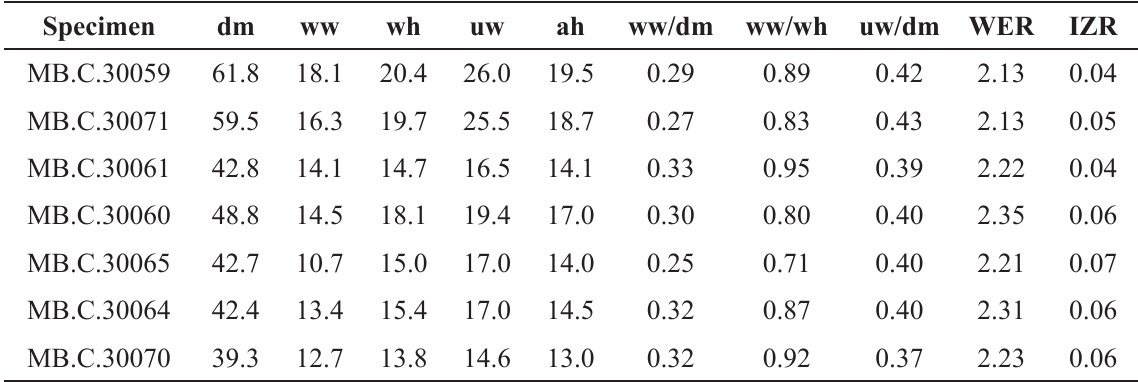
Table 32. Conch dimensions (partly estimated) and ratios of selected specimens of Abichites ovalis Korn & Hairapetian sp. nov. from Baghuk